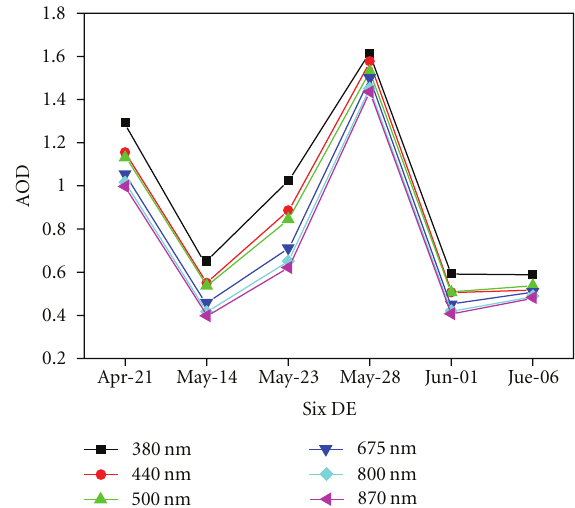
Figure 5: Spectral variation of Microtops-II AOD during the six